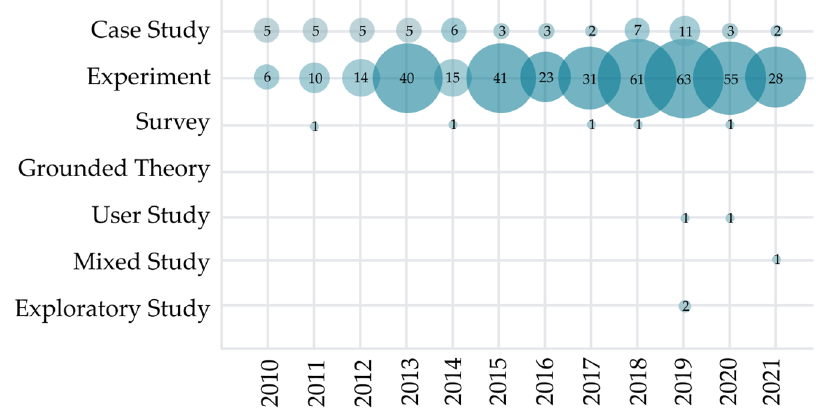
Figure 9. Number of studies by year and research method type.